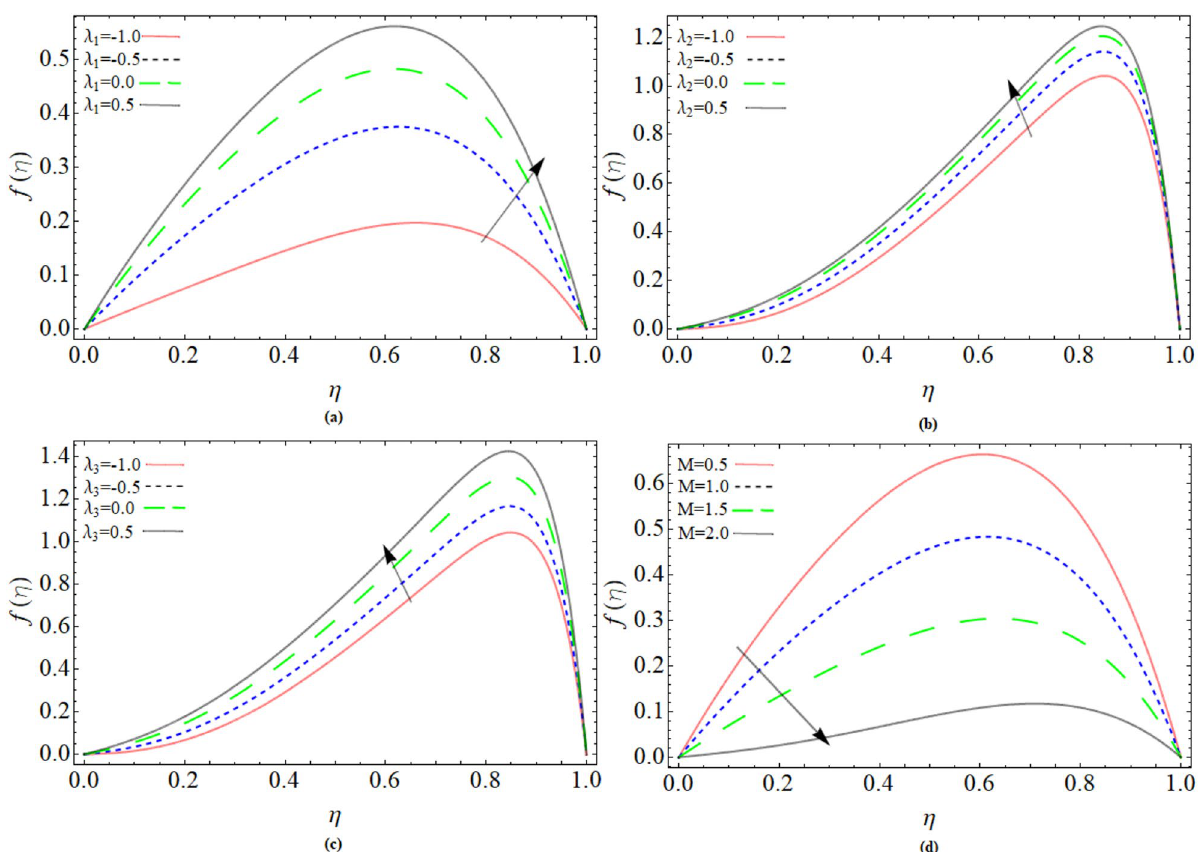
Figure 2. Buoyancy convection term due to temperature (cid:31) 1 , concentration (cid:31) 2 and microorganism (cid:31) 3 and magnetic parameter M effect on velocity profile f (η)